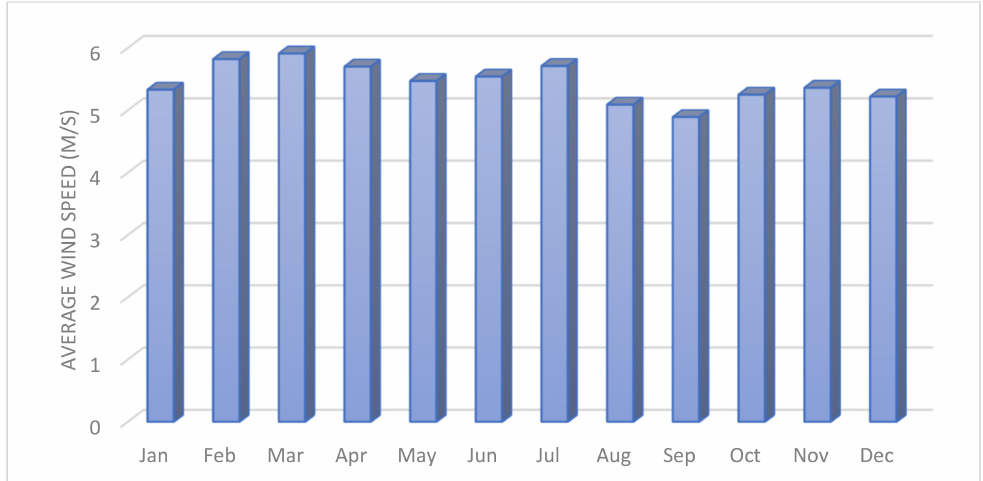
Figure 7. The annual average wind speed of the selected case